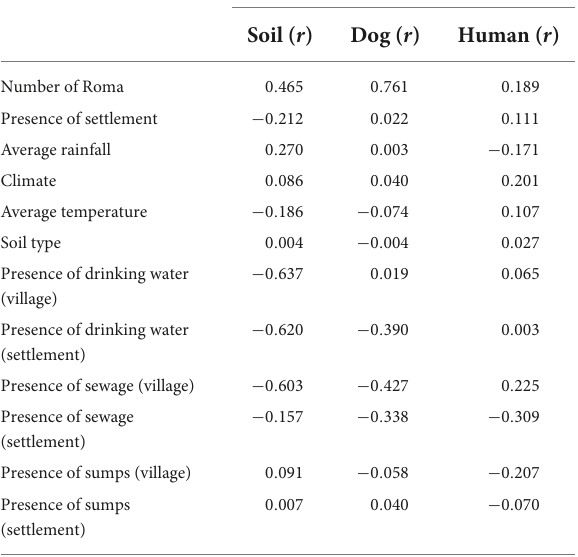
TABLE 5 The established correlation coefficients between the relationship of individual environmental, demographic, and climatic data and type of sample (human, dog, and soil